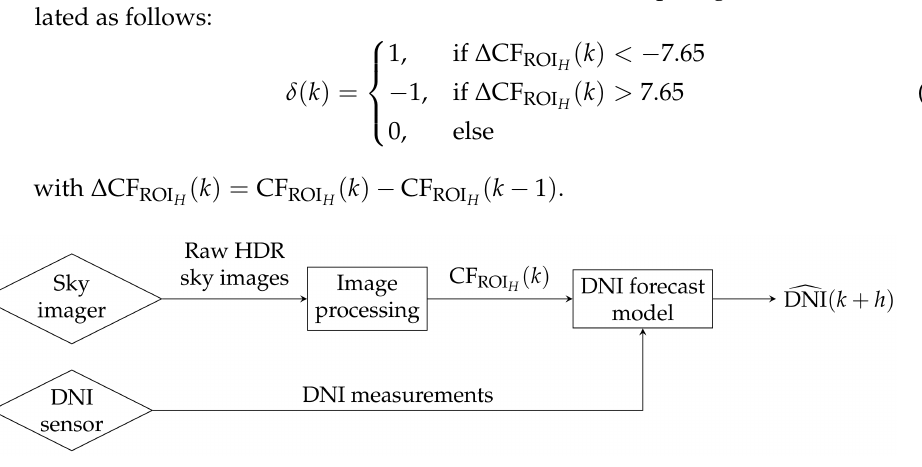
Figure 13. Global architecture of the proposed forecast model, showing two main blocks: image processing and DNI forecasting. CF ROI is the cloud fraction in the ROI. The interested reader is H referred to [24] for details about the image processing block. Table 3. Optimal LSTM architecture for each forecast horizon H